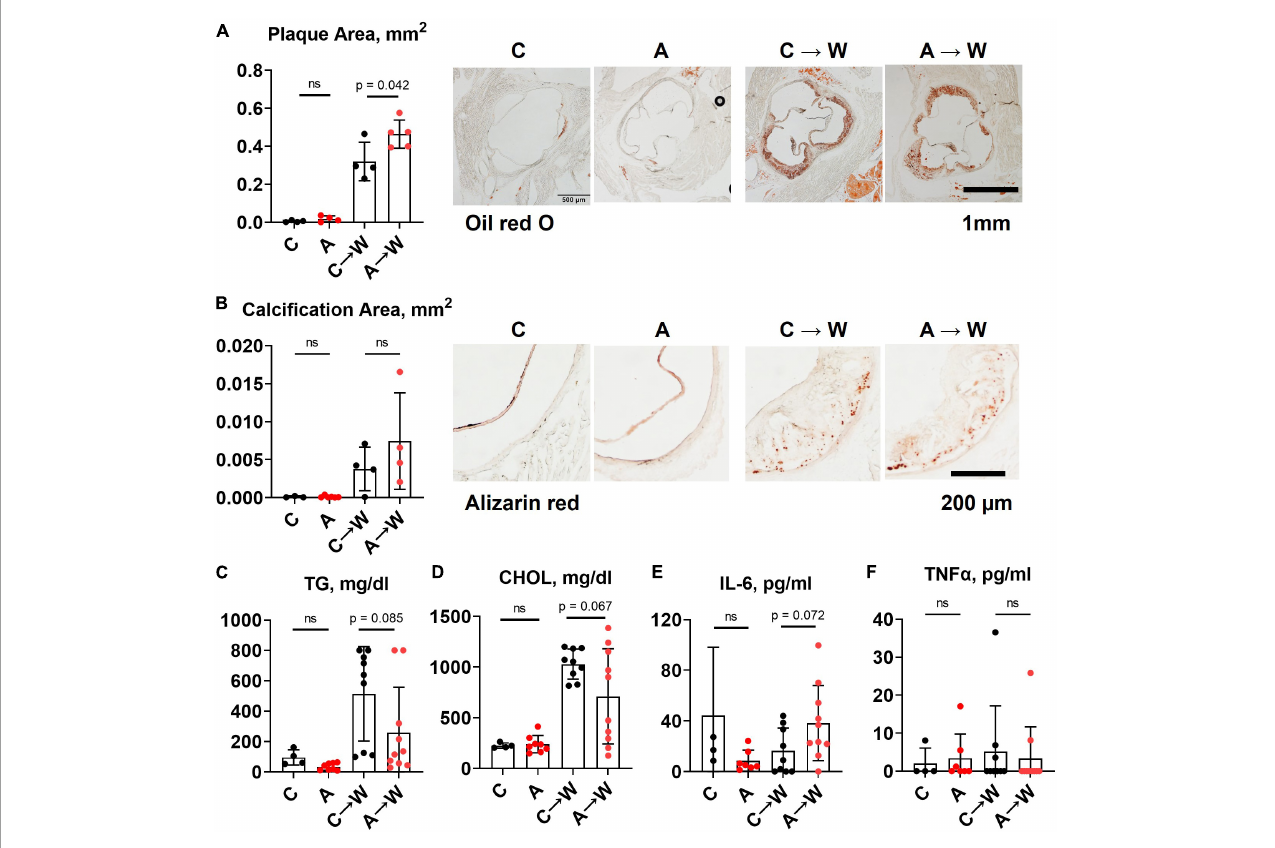
FIGURE6 Aortic root atherosclerosis, plasma lipids, and inflammatory cytokines in WHC mice pre-treated with 0.2% adenine before a western diet. (A) Representative images and quantification of Oil red O staining of the aortic root. (B) Representative images and quantification of alizarin red staining of the aortic root. (C) Plasma triglycerides (TG). (D) Cholesterol (CHOL). (E) Interleukin-6 (IL-6). (F) Tumor necrosis factor alpha (TNF α ). n = 4–6 per group; two-way ANOVA; ns, not